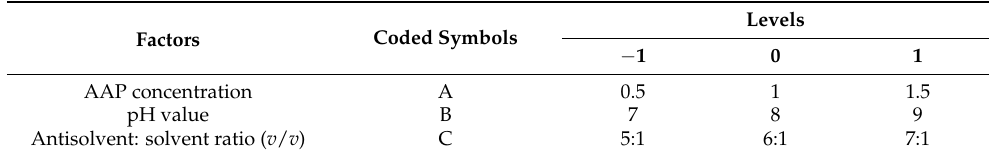
Table 3. BBD level table and coding of experimental